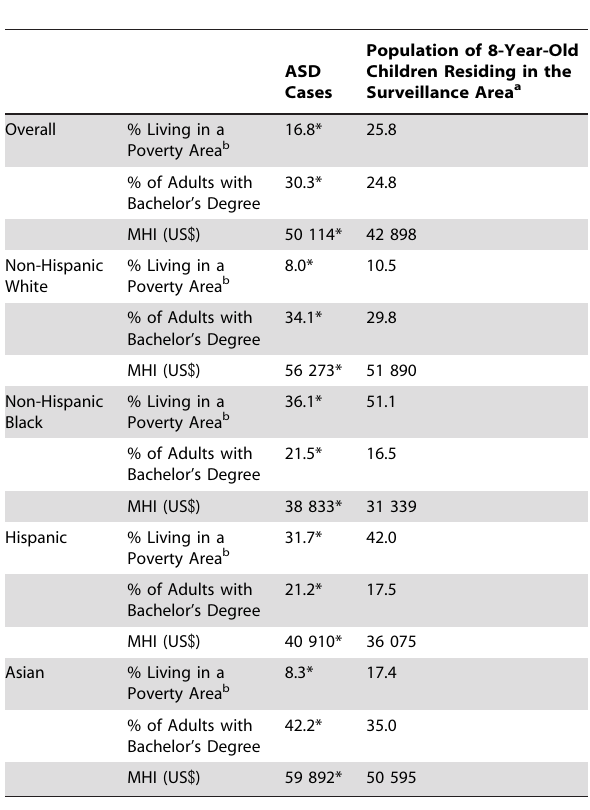
Table 2. Socioeconomic Indicators for ASD Cases and the Population of 8-Year-Old Children in the Surveillance